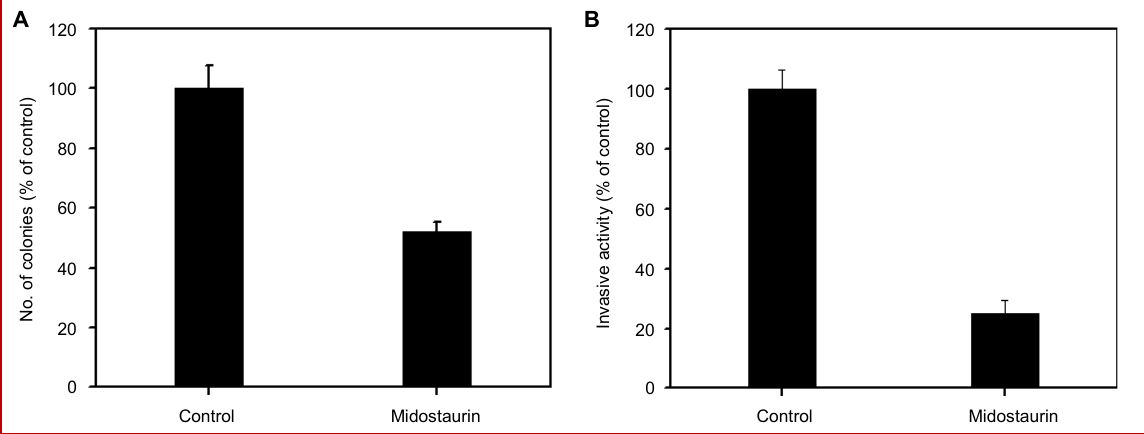
Figure 4: A. Colony forming activity assay on midostaurin treated DU145 cells for one week. Values are given as mean ± SD of three independent experiments. B. Effects of midostaurin on invasive activity of DU145 cells. Values are mean ± SD of triplicate